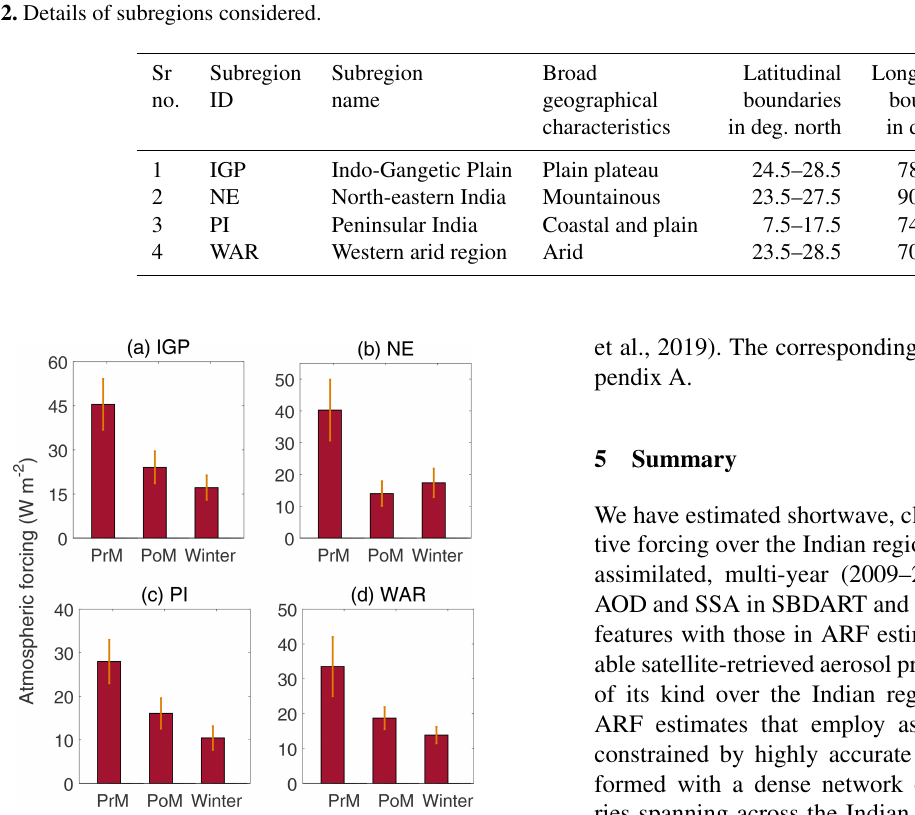
Figure 12. The climatological seasonal variation of atmospheric ab- sorption due to aerosols estimated using assimilated aerosol prod- ucts and averaged over four subregions: (a) IGP, (b) NE, (c) PI and (d)